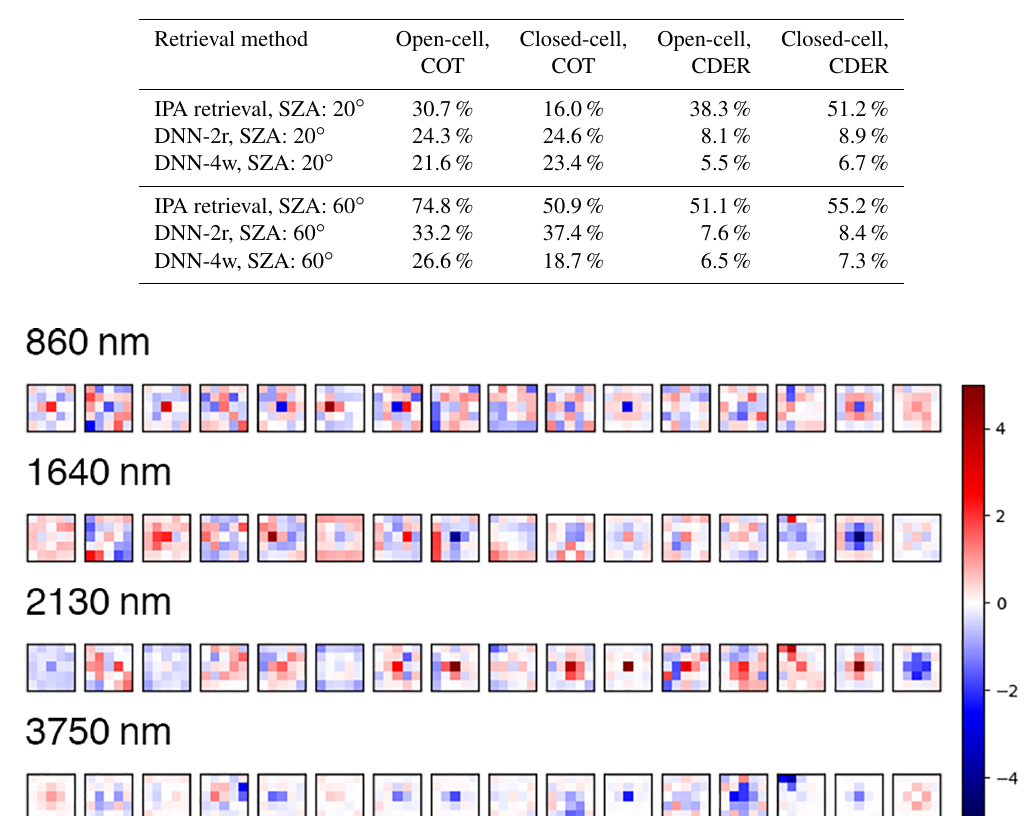
Figure 8. Selected examples of the filter for 5 × 5 pixels at each wavelength in the first convolutional layer in DNN-4w. Only 16 of 100 filters for each wavelength are shown here. The color shade denotes the filter weight. The sunlight is from the